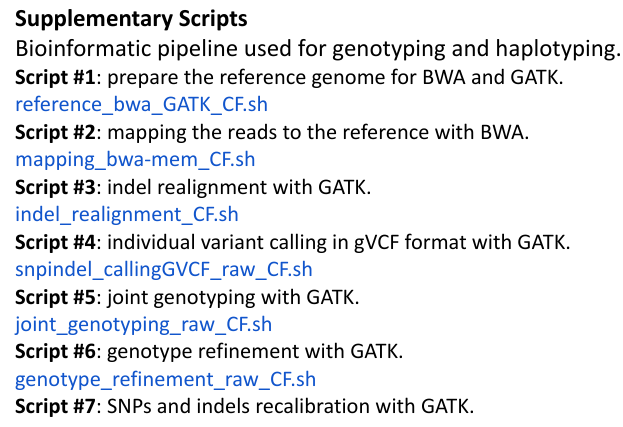
Table S2 Correlation between chromosomes of the individual C. robusta ancestry fraction. Table S3 Demographic results with moments – excluding chromosome 5. Table S4 Demographic results with moments – including chromosome 5. Table S5 Description of the Supplementary